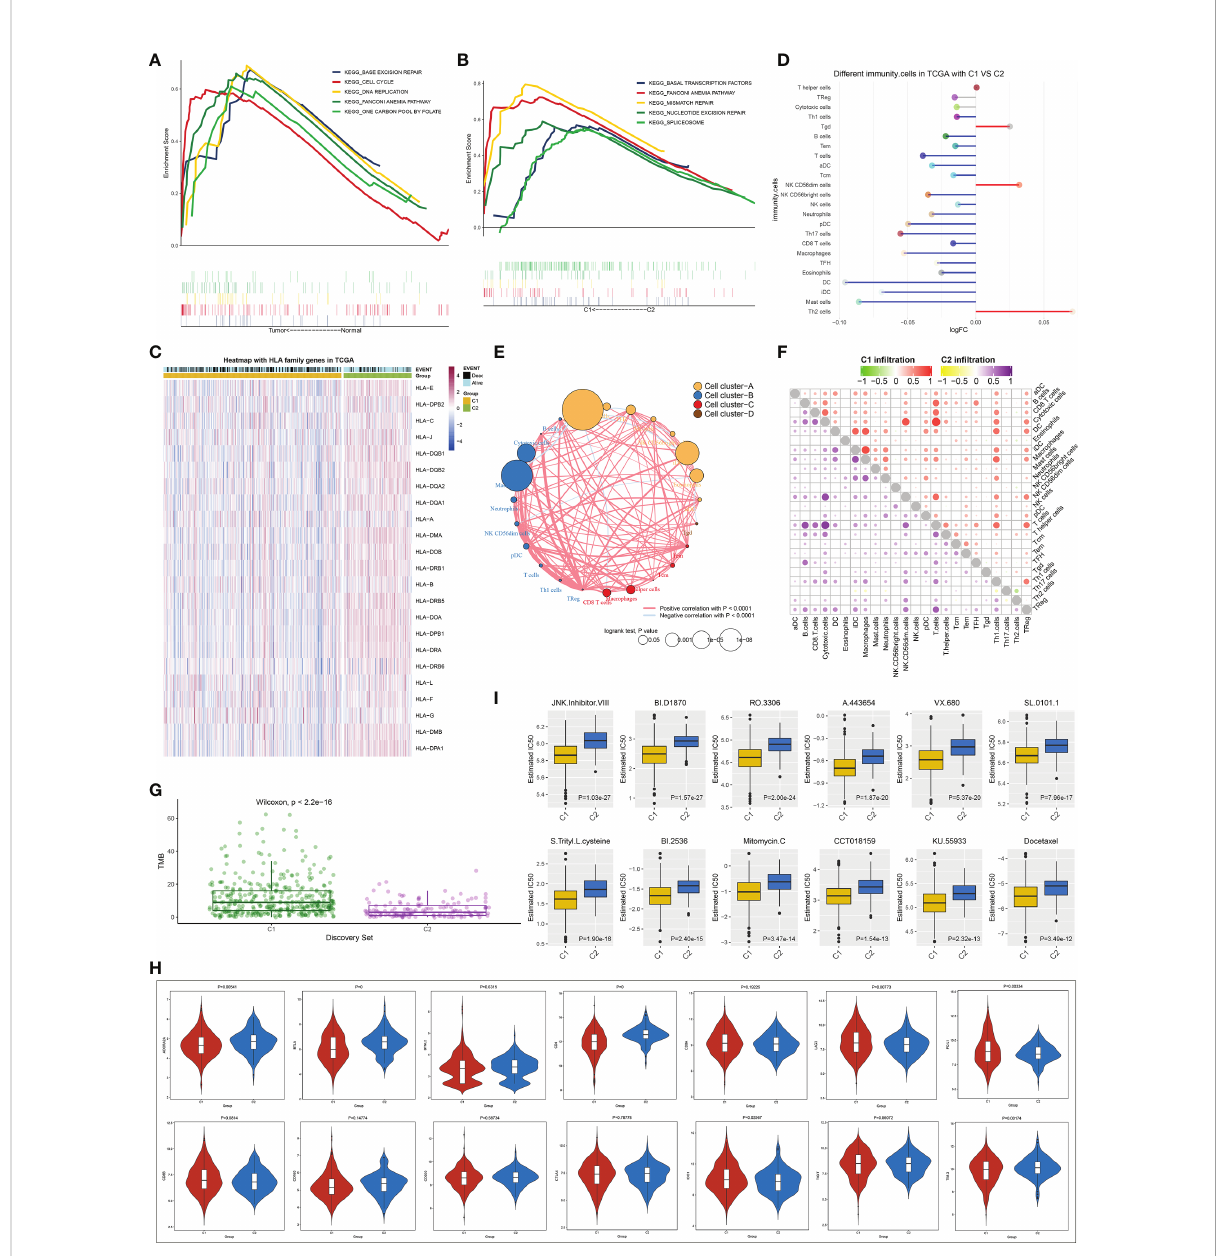
FIGURE 3 Signaling pathways, antitumor immunity and drug sensitivity in two immune cell in fi ltration-based subtypes. (A) KEGG pathways with different enrichment between LUAD and normal lung tissues. (B) KEGG pathways were distinctly enriched between C1 and C2 subtypes. (C) Heatmap of the levels of MHC molecules in two molecular subtypes. (D) Differences in the abundance of immune in fi ltrate between subtypes. (E) Cluster analysis of various immune cell types across LUAD. (F) Correlation of different immune cells with one another within C1 or C2 subtype. (G) Difference in TMB score between subtypes. (H) Comparison of the mRNA levels of known immune checkpoints in two subtypes. (I) Estimated IC50 values of small molecular compounds in two subtypes. KEGG, Kyoto Encyclopedia of Genes and Genomes; LUAD, lung adenocarcinoma; TMB, tumor mutational